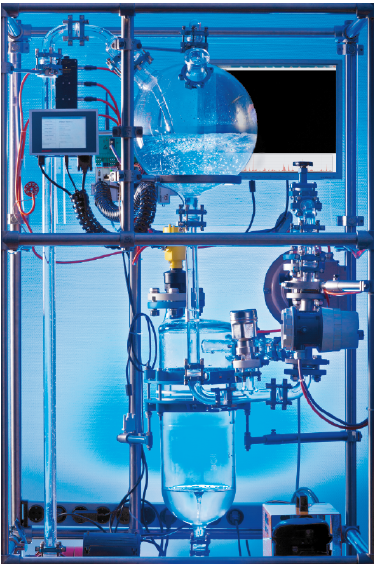
Figure 3. Experimental setup of the laboratory